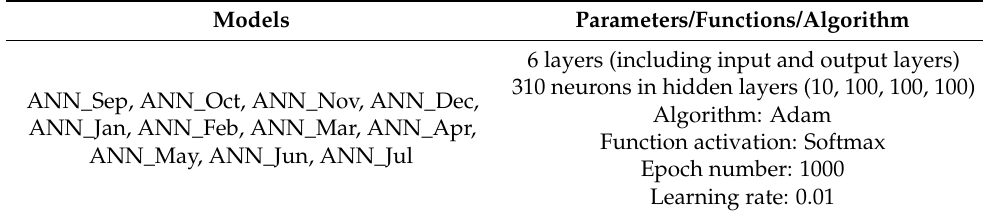
Table 5. Adopted hyper-parameter and functions of the trained models.